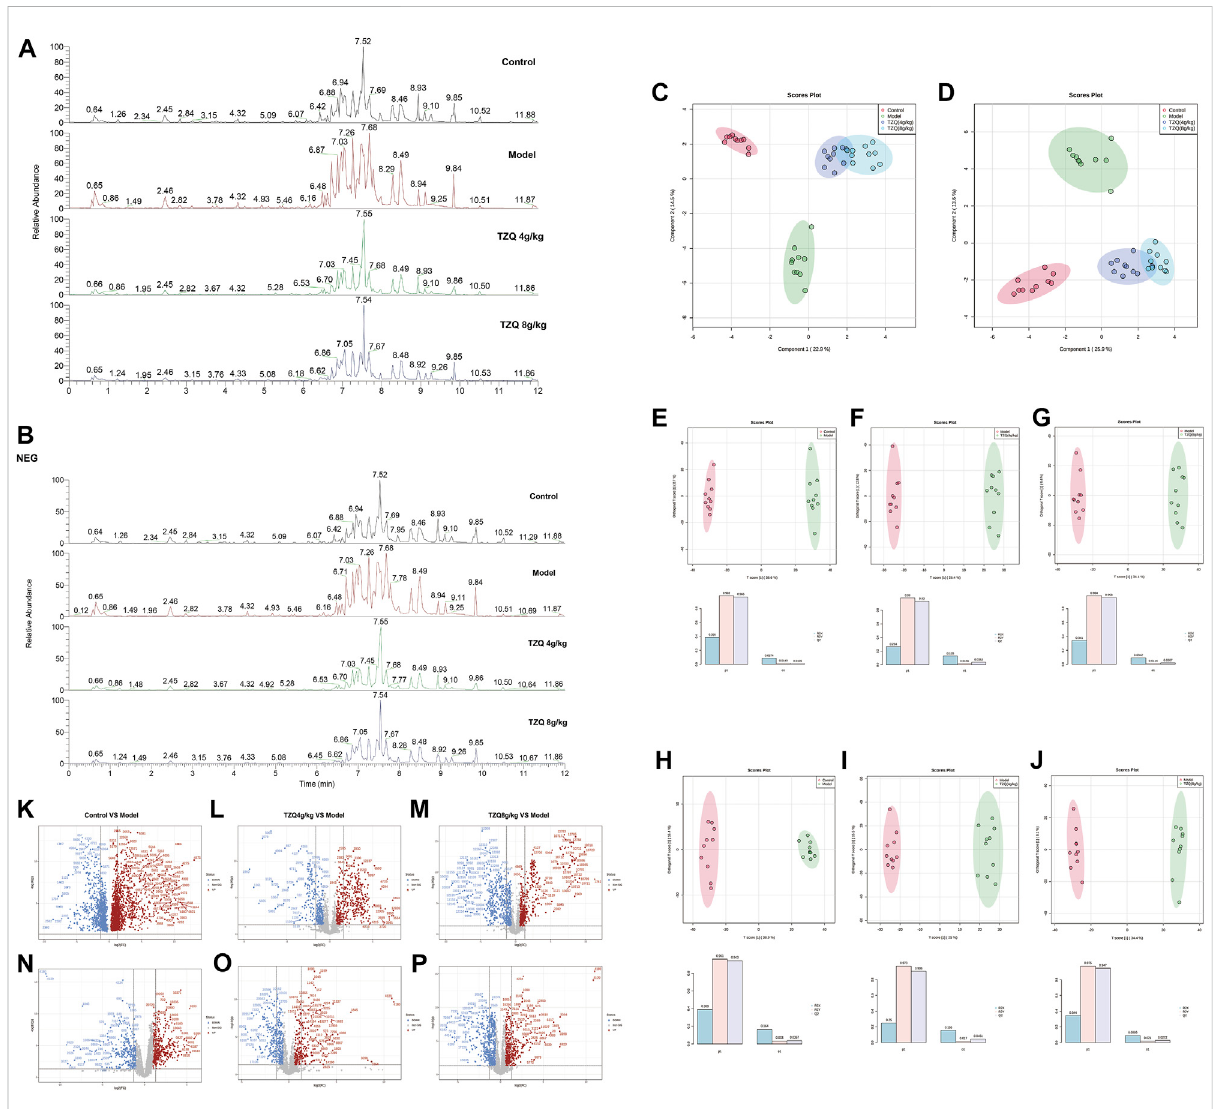
FIGURE 6 TZQ metabolic biomarker screening in the treatment of atherosclerosis (AS). n = 10 mice for each group. (A) : Total ion chromatogram of ApoE − / − mouse serum samples in positive ion mode. (B) : Total ion current map of ApoE − / − mouse serum samples in negative ion mode. (C) : Orthogonal partial least squares analysis (OPLS-DA) score plot of serum samples in positive ion mode. (D) : OPLS-DA score map of serum samples in negative ion mode. (E – G) : OPLS-DA score plot of serum samples in positive ion mode; (E) : Control vs. Model; (F) : Model vs. TZQ 4 g/kg; (G) : Model vs. TZQ 8 g/kg; (H – J) : OPLS-DA score plot of serum samples in negative ion mode. (H) : Control vs. Model; (I) : Model vs. TZQ 4 g/kg; (J) : Model vs. TZQ 8 g/kg. (K – M) : Volcano plot of serum samples in positive ion mode; (K) : Control vs. Model; (L) : Model vs. TZQ 4 g/kg; (M) : Model